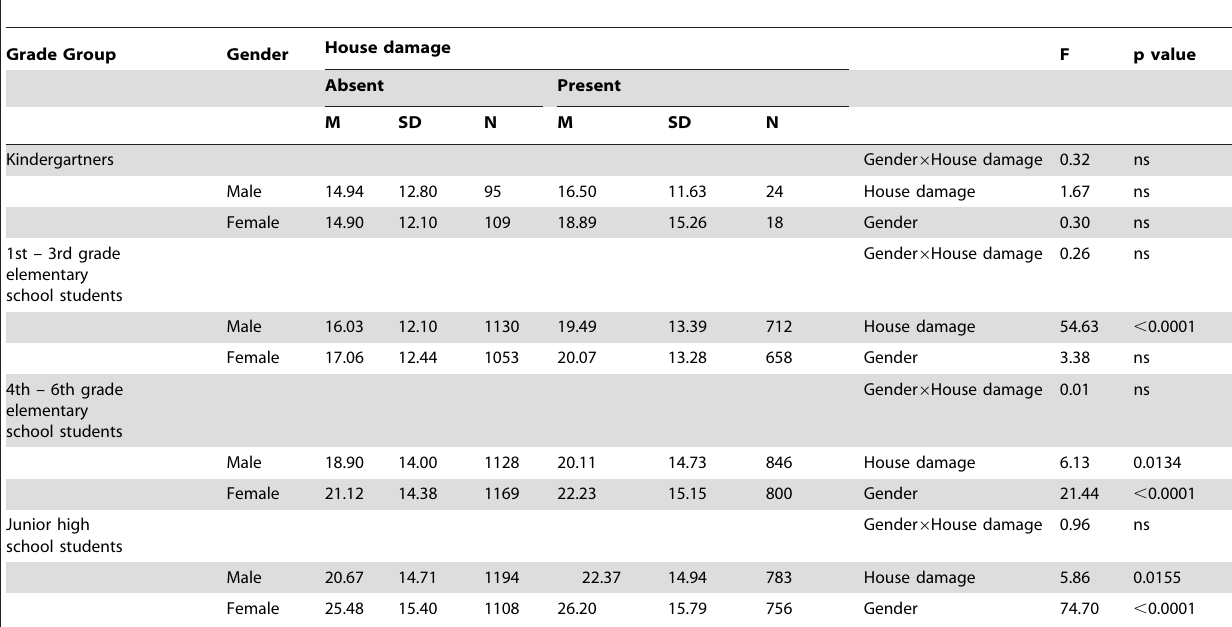
Table 3. Average PTSSC-15 score (grade & gender & house